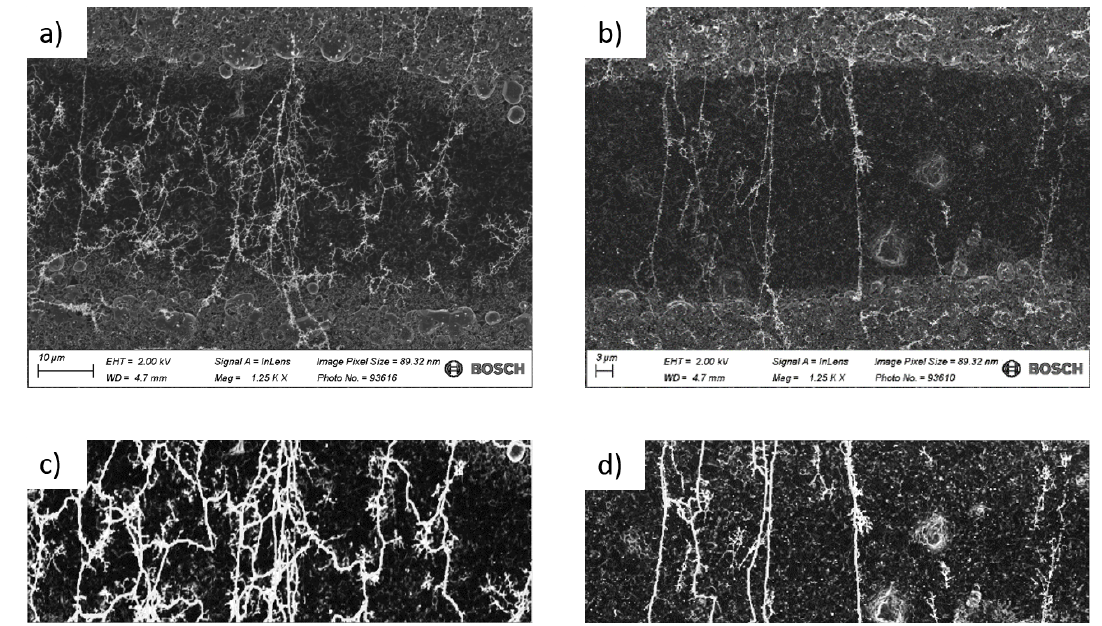
Figure 7. ( a–b ) Soot structures in selected sections on the IDE after soot loading using the regular operating strategy and prepolarization at high temperatures, respectively. ( c–d ) Screenshots from the MATLAB ® evaluation of the soot structures from ( a–b ). Spotted soot paths connecting the electrodes are marked with thick white lines.